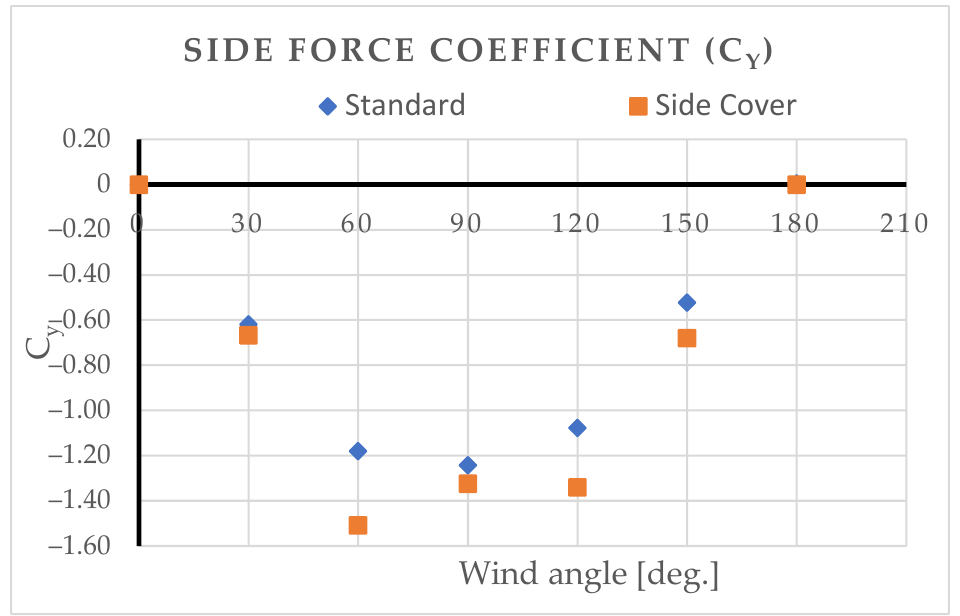
Figure 34. Effect of side covers on the resistance coefficient at different wind angles.